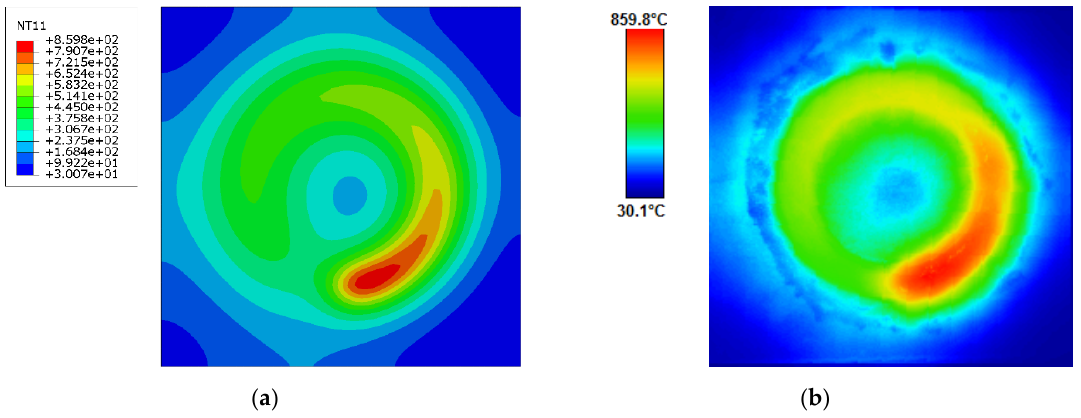
Figure 6. Full field temperature distribution on upper surface of welded model 127 s after beginning of welding process: ( a ) Numerical simulation; ( b ) Thermographic measurement.